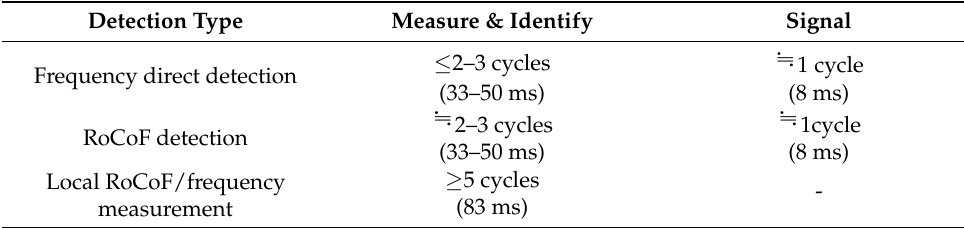
Table 2. Frequency/RoCoF detection and signaling time [14].